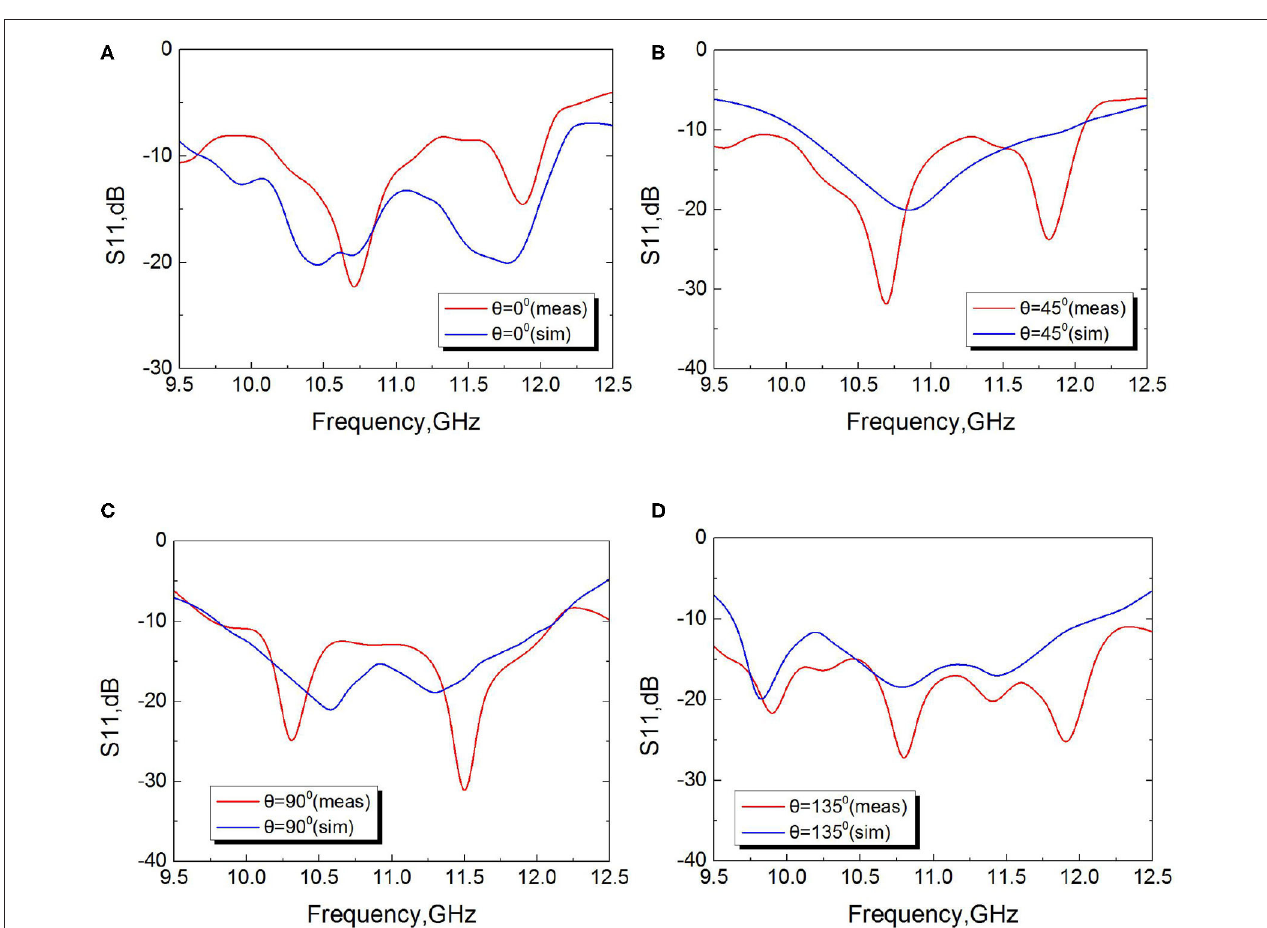
FIGURE 7 | Measured and simulated reflection coefficient S11 with different rotation angle. (A) θ